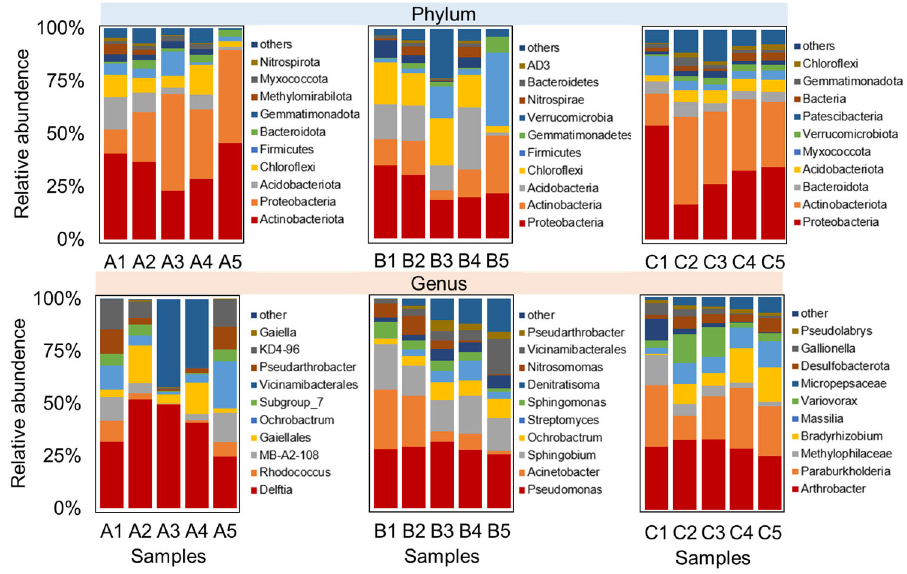
Figure 5. Histogram of the species abundance in the microbial community.